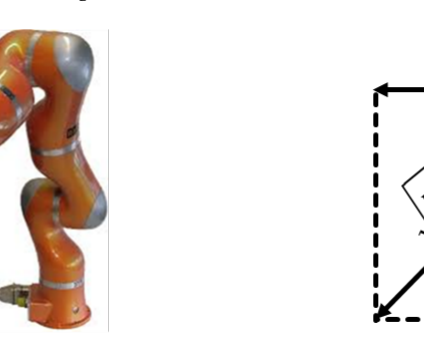
Figure 3. Tool gravity mapped on the force